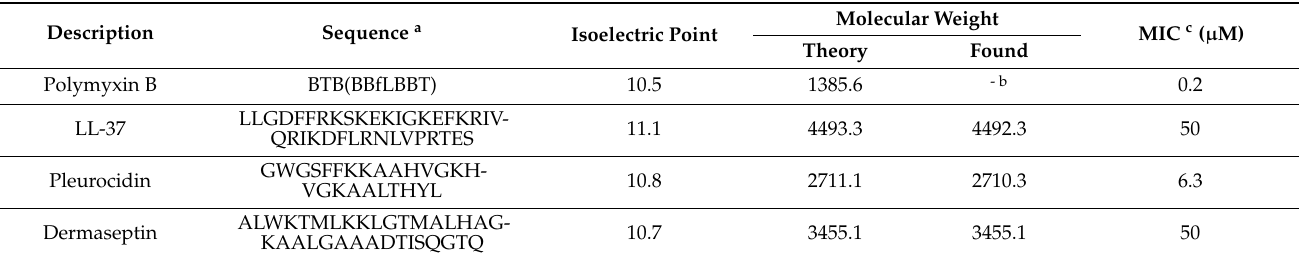
Table 1. AMP sequences and MIC under assay